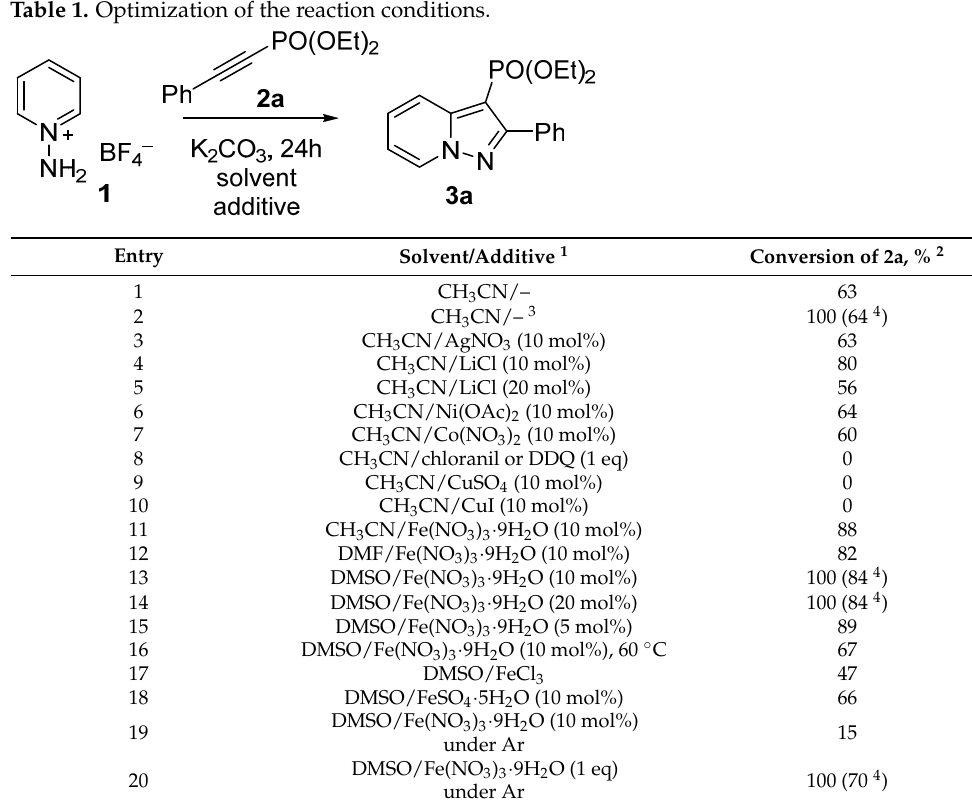
Table 1. Optimization of the reaction conditions.